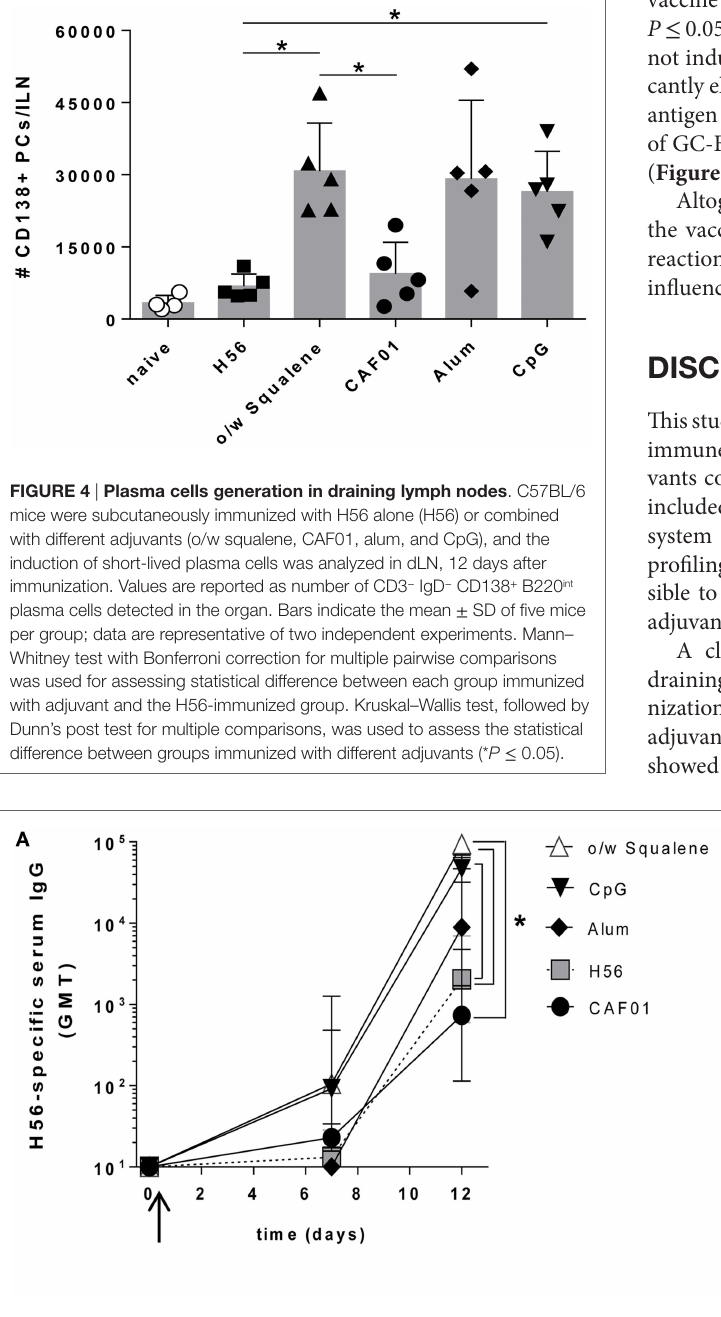
FigUre 5 | early antigen-specific igg response . C57BL/6 mice were subcutaneously immunized with H56 alone (H56) or combined with different adjuvants (o/w squalene, CAF01, alum, and CpG), and humoral response was analyzed in blood (a) H56-specific IgG serum response detected by ELISA on sera collected 7 and 12 days after SC immunization. Antibody titers were expressed as the reciprocal of the highest dilution with an OD value ≥ 0.2 after background subtraction. Values are reported as GMT ± SD of five to eight mice per group, from two independent experiments. Mann–Whitney test, with Bonferroni correction for multiple pairwise comparisons, was used for assessing the statistical difference between each group immunized with adjuvant and the H56-immunized group. Kruskal–Wallis test, followed by Dunn’s post test for multiple comparisons, was used to assess the statistical difference between groups immunized with different adjuvants (* P ≤ 0.05). (B) Ratio of H56-specific IgG1 and IgG2c subclasses assessed in serum of each animal. Data are reported as mean ± SEM for each